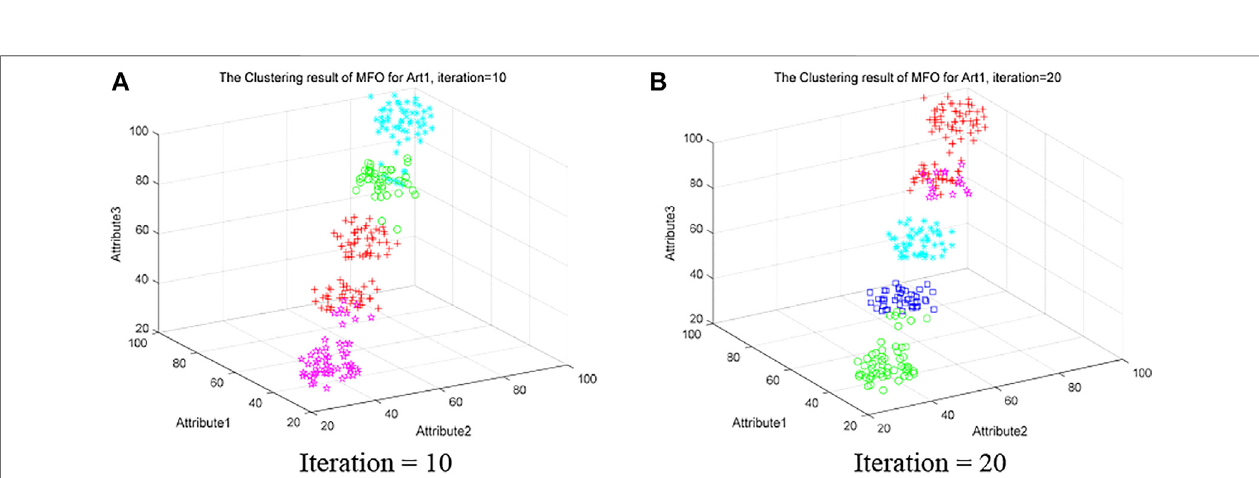
Frontiers in Bioengineering and Biotechnology |